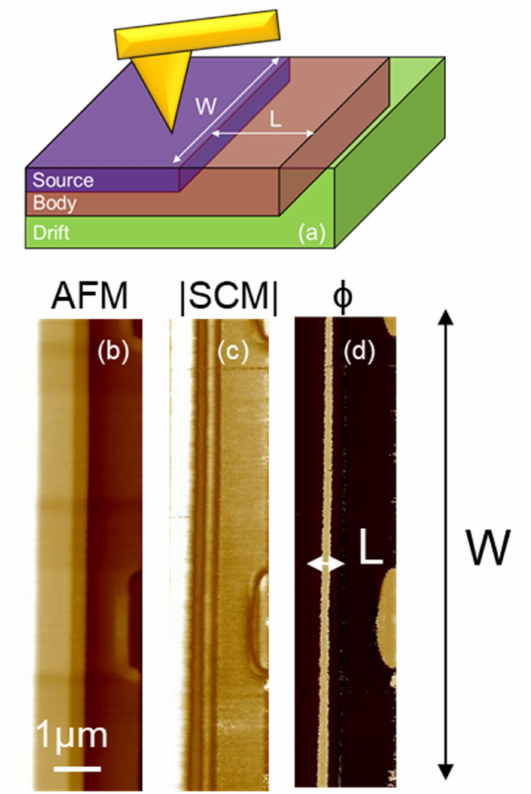
Figure 3. ( a ) Schematic description of the in-plan 2D SCM measurements on the MOSFET channel along W and across the L directions. ( b ) AFM morphology, ( c ) SCM amplitude, and ( d ) SCM phase ( φ ) of the reference